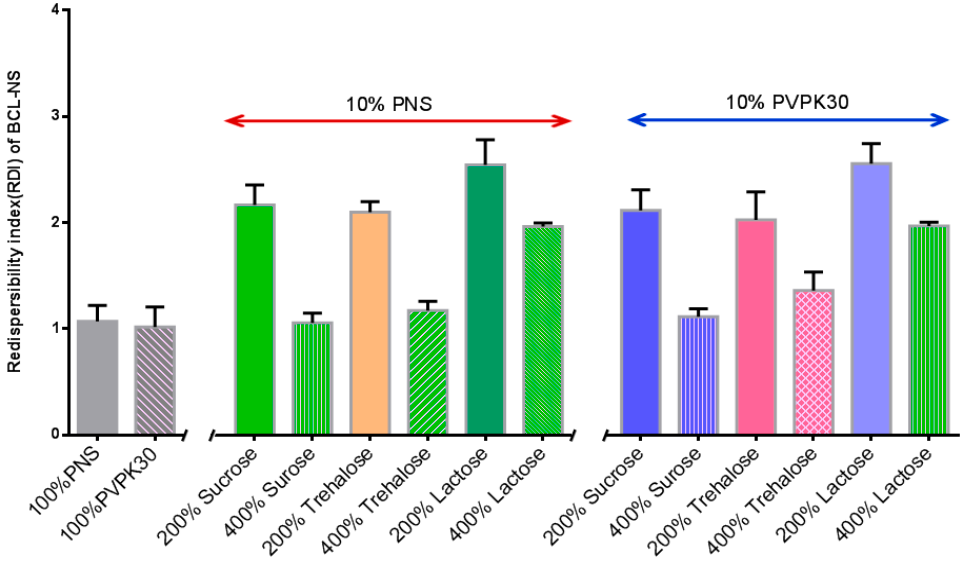
Figure 6. Redispersibility of the freeze-dried BCL-NC with 10% PNS and combined with different concentrations of matrix formers (mean ± S.D., n = 3).